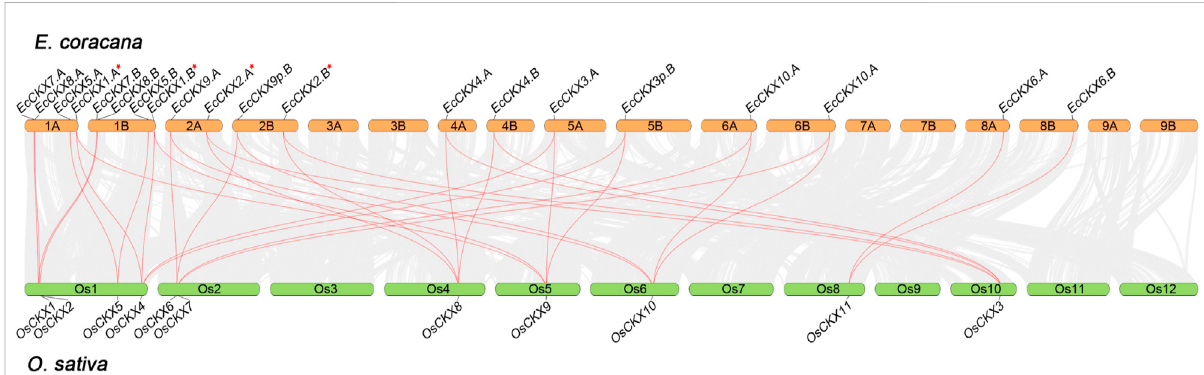
FIGURE 5 Synteny analysis of CKX genes between E. coracana and O. sativa species. The collinear blocks between O. sativa and E. coracana species are shown with gray lines, while syntenic pairs of CKX genes are highlighted in red. The chromosome number is indicated above each respective chromosome. A red asterix denotes genes identical to previously sequenced and characterized EcCKX1 and EcCKX2